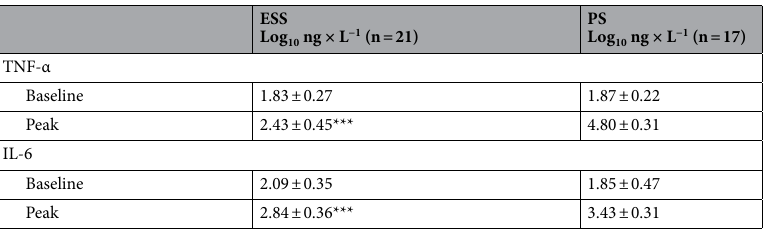
Table 1. Baseline at 0 h before the bacterial challenge and the highest (peak) plasma levels of TNF-α and IL-6 in animals with early secondary sepsis (ESS) and primary sepsis (PS). Data are presented as mean ± SD. Student’s unpaired t-test was used to compare the differences between ESS and PS. *** p < 0.001 ESS versus